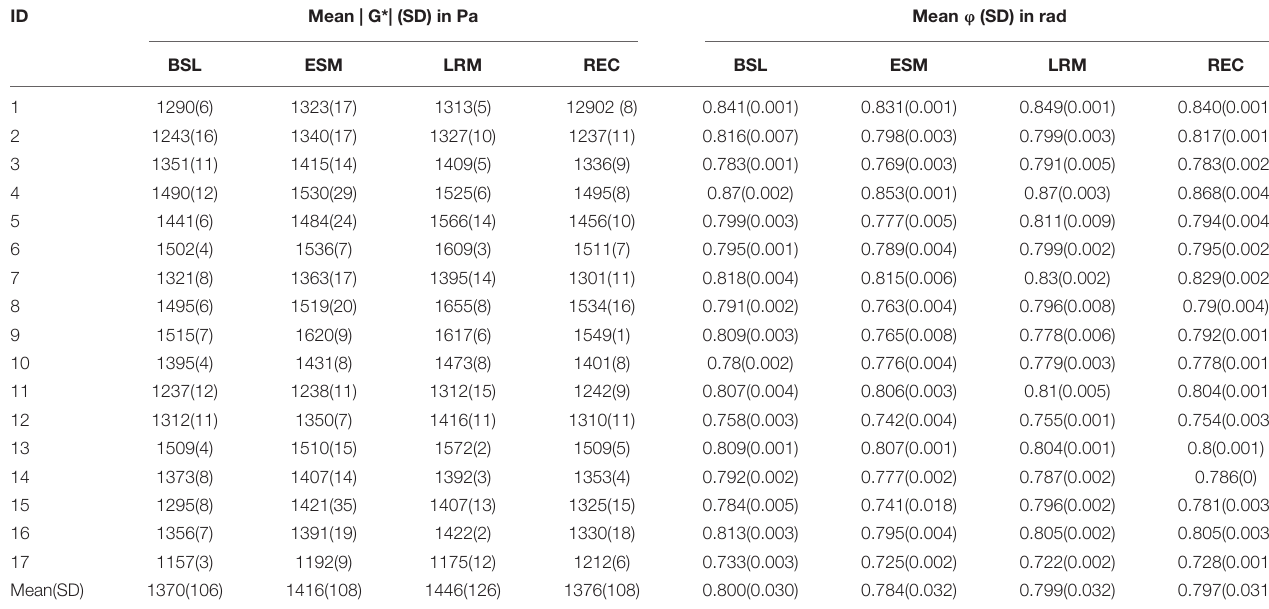
FIGURE 3 | Representative Fourier power spectra with three aliased excitation frequencies for one motion-encoding component above and wave deflections for three encoding components and three vibration frequencies below. (A) Power spectra for vibrations at 31-Hz regimen. Color coding indicates the respective vibration frequency with Gaussian bandpass filter used for Hilbert transformation. The frequency axis is scaled from 0 to the Nyquist frequency in Hz, which is determined by the sampling rate of 5.4 Hz. Stroboscopic sampling of multiharmonic vibrations causes all frequencies to be aliased within this limited frequency window. (B) Representative wave images after frequency decomposition for the three encoding components using the 31-Hz regimen (30.03, 30.91, 31.8 Hz). [ (cid:12) , ↔ , (cid:108) denote deflections through-plane (head-to-feet), left-right, and up-down (anterior-posterior), respectively]. TABLE 2 | Mean | G*| (SD) in Pa and mean ϕ (SD) in rad for each phase and participant in the Valsalva maneuver experiments using the 31-Hz regimen (30.03, 30.91, 31.8